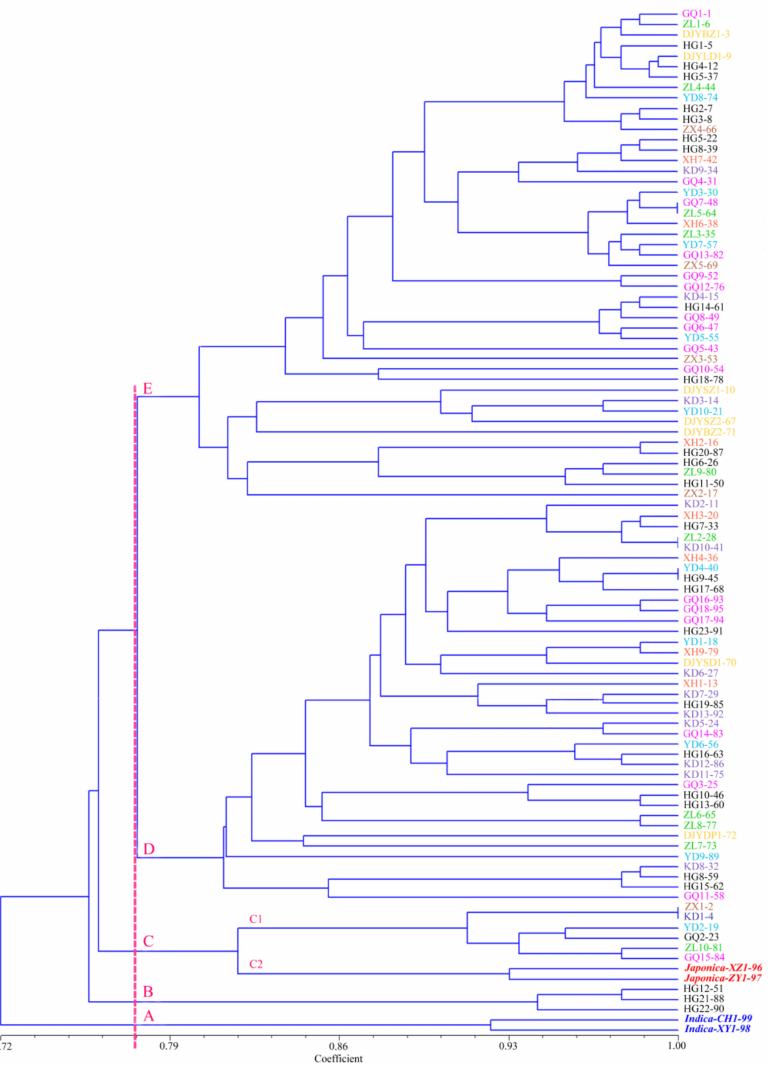
Figure 4. Cluster dendrogram of 99 rice landrace based on genetic similarity. No. 96–99 are the control varieties, in which ZY1-97 and XY1-98 are glutinous japonica , XZ1-96 and CH1-99 are non-glutinous indica